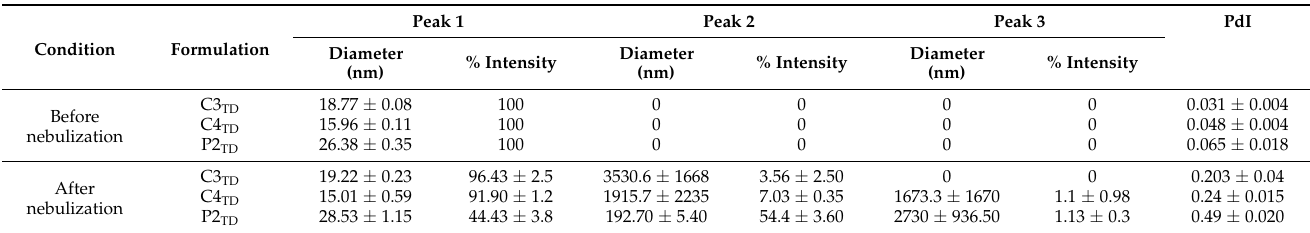
Table 7. Globule size distribution by intensity of 50-fold saline diluted TD-loaded NE formulations before and after